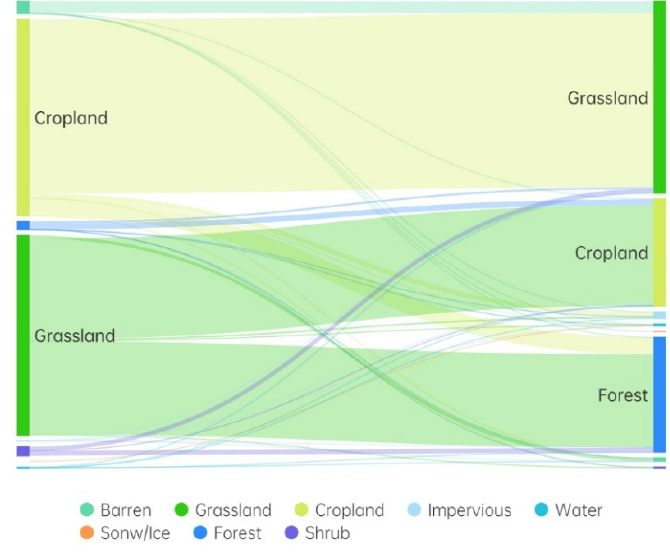
Figure 9. Shifts in land use types in Area 4 from 2000 to 2021.